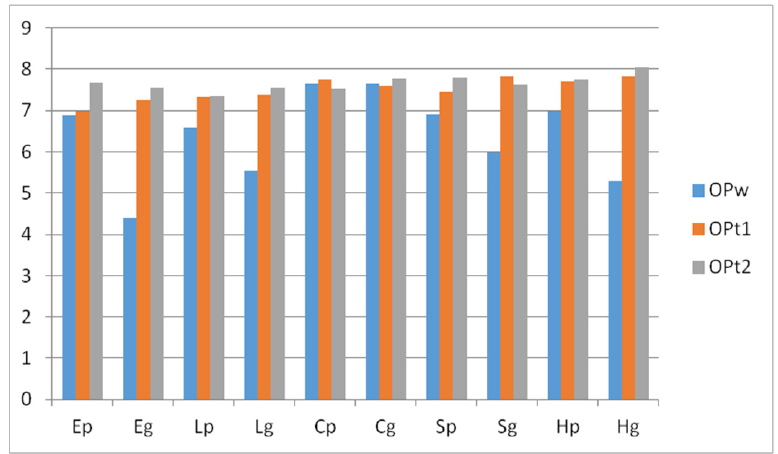
Figure 3. Mean values of the OP parameter, before and after thermal aging.